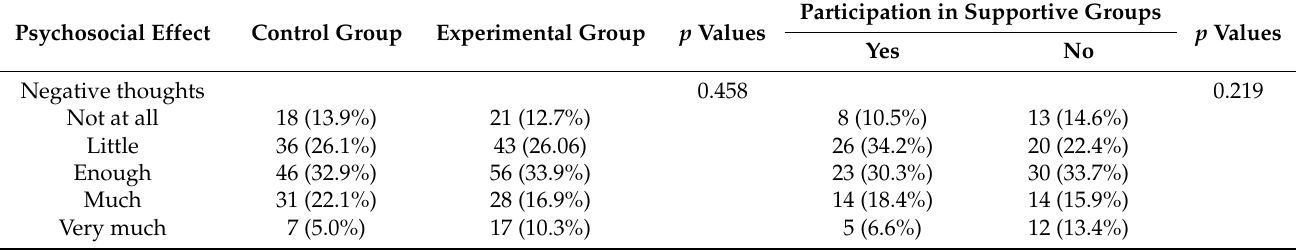
Table 7. Negative thoughts about the